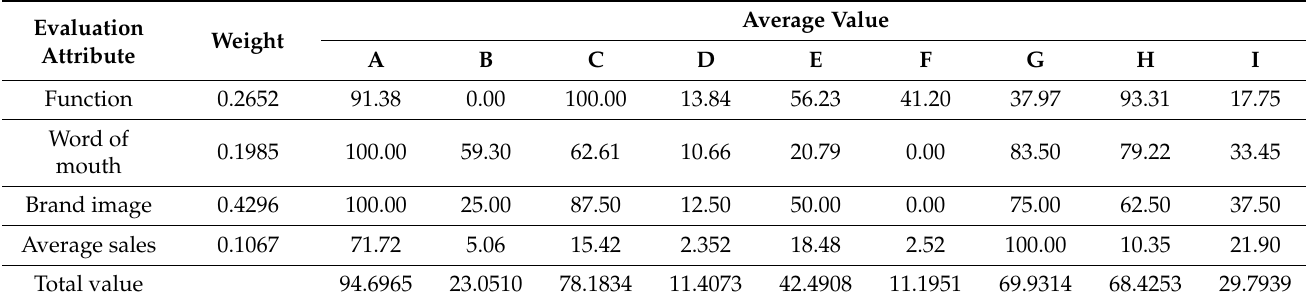
Table 12. The brand performance analysis by average weight analysis.